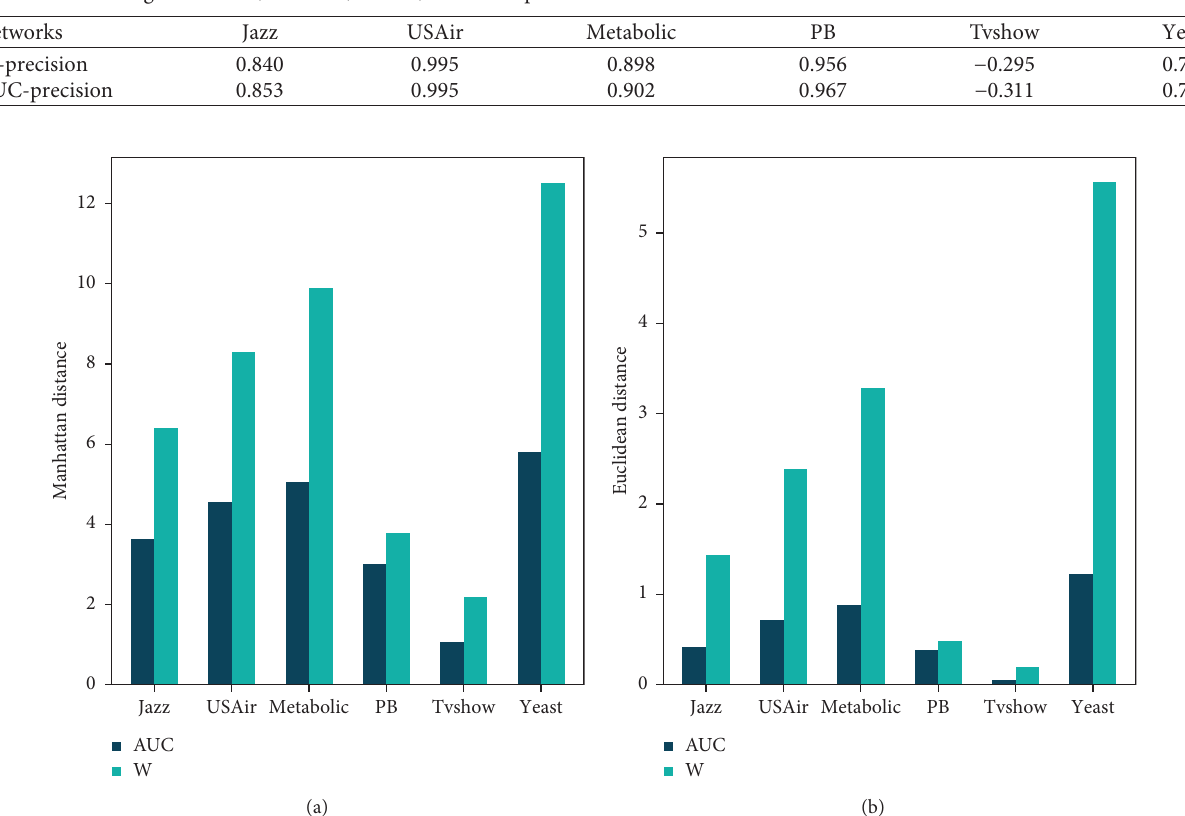
Figure 4: Total distance between the measure performance calculated by (a) Manhattan distance and (b) Euclidean distance.